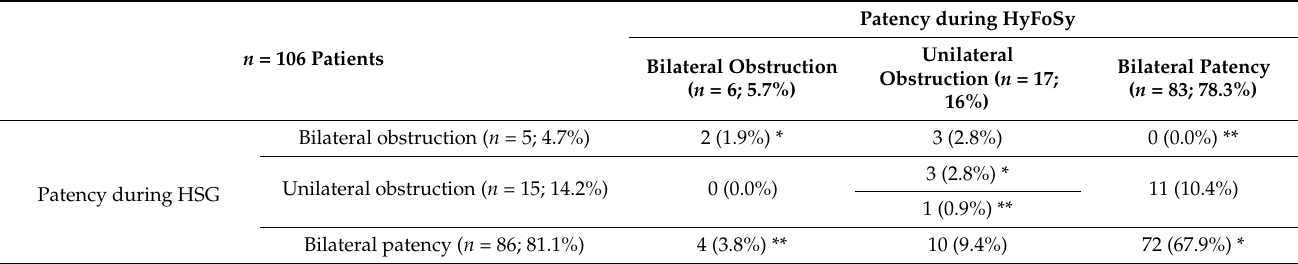
Table 2. Patency